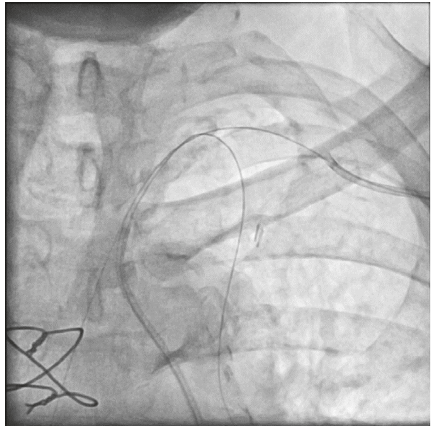
Figure 2: Retrograde wiring of the SA via the left radial artery and anterograde wiring of the LIMA via the left femoral artery. SA, subclavian artery; LIMA, left internal mammary artery.